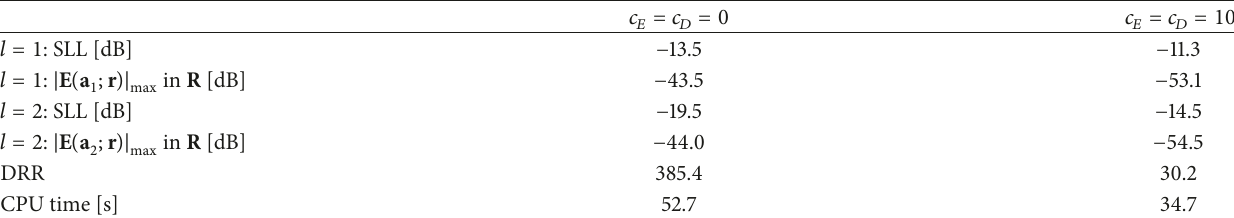
Table 2: Second application: overall